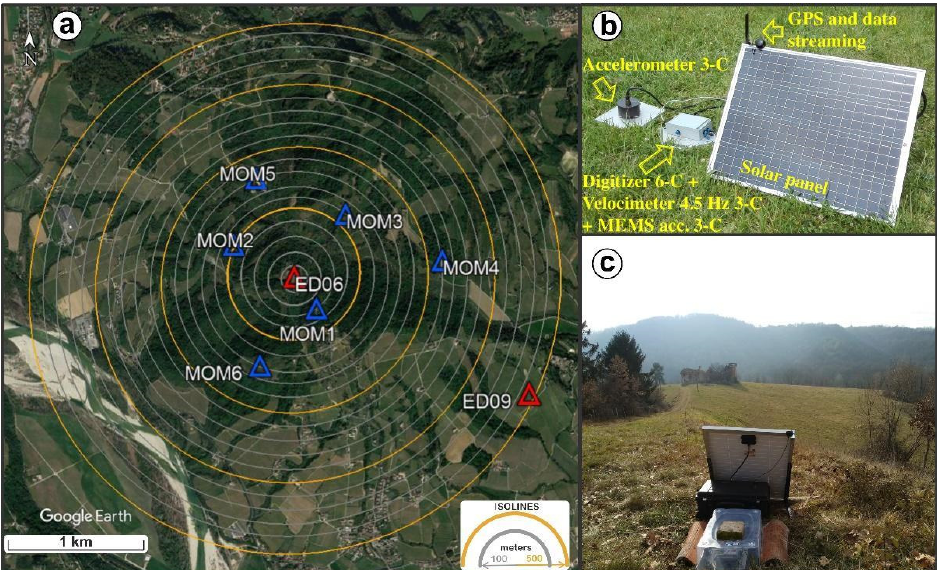
Figure 2. ( a ) Geometry of the Collalto array deployed in the Susegana (TV) municipality for the field experiment. The RSC and MOMA stations are represented by red and blue triangles, respevtively. ( b ) Example of MOMA station configuration equipped with a 3C geophone (4.5 Hz), a 3C MEMS accelerometer. An additional external accelerometer might be added but it was not installed during this experiment. The seismic station is also equipped with a 12 V solar panel, GPS and radio antennas for communication to a local control system. ( c ) Example of field seismic station (MOM3) installed during the Collalto experiment. Map Data: Google Earth © Google 2022.